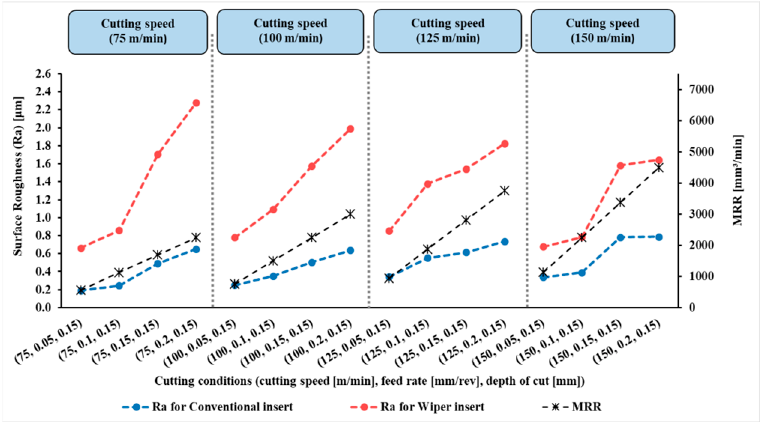
Figure 4. Surface roughness (Ra) and material removal rate (MRR) for AISI 4340 workpieces machined by wiper and conventional inserts at depth of cut ( a p ) of 0.10 mm and variable cutting speeds and feed rates (reproduced results originally reported in [6]).